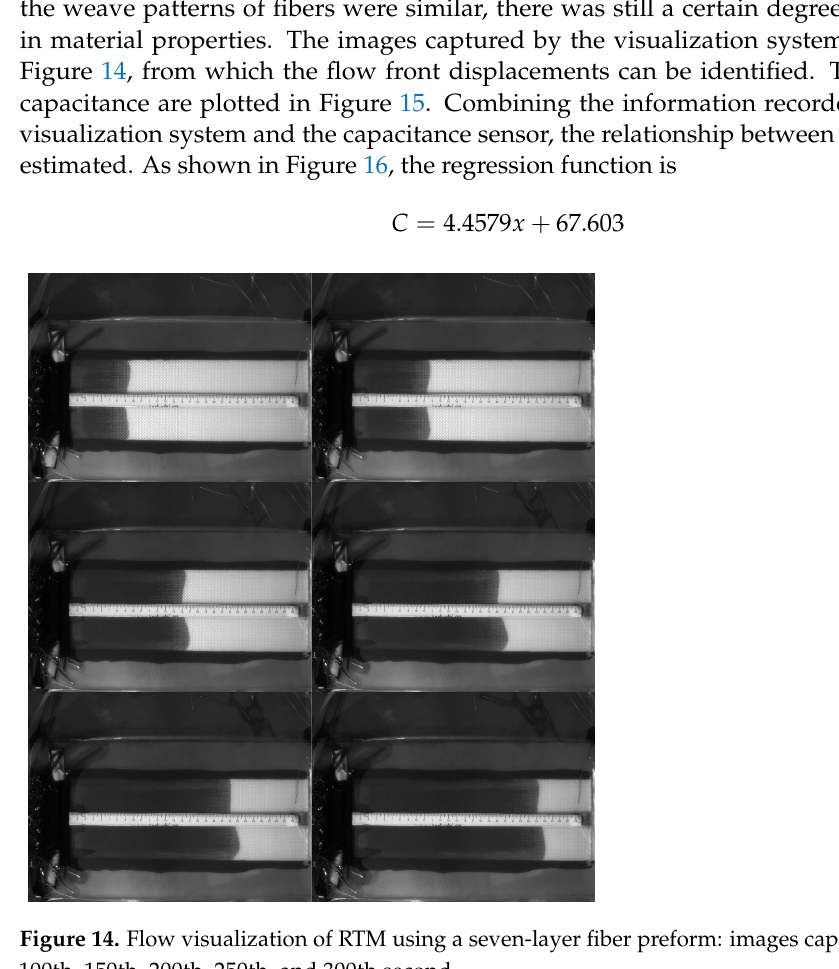
Figure 13. Relationship between flow front displacement and capacitance in the second RTM experiment using a nine-layer fiber preform.